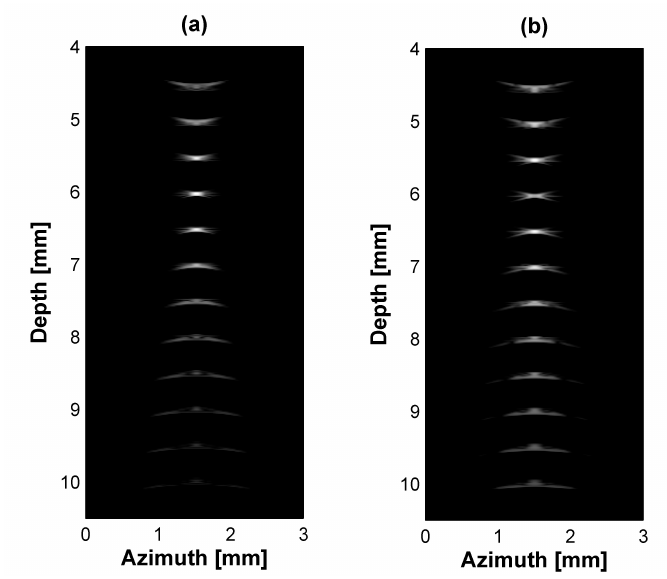
Figure 4. Point target simulation results for ( a ) single element and ( b ) dual-element transducer with phase inversion. All figures are logarithmically compressed with a dynamic range of 60 dB.